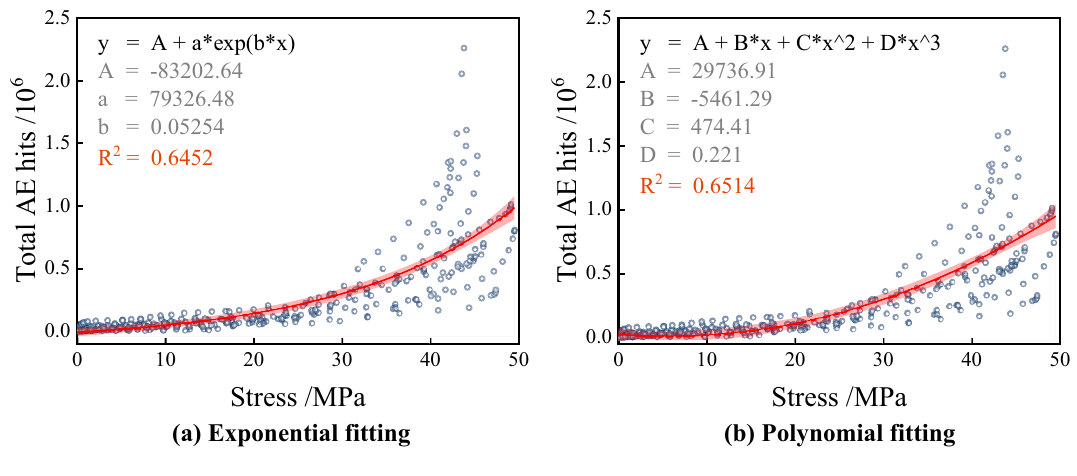
Figure 12. Fitting curve of total AE hits and